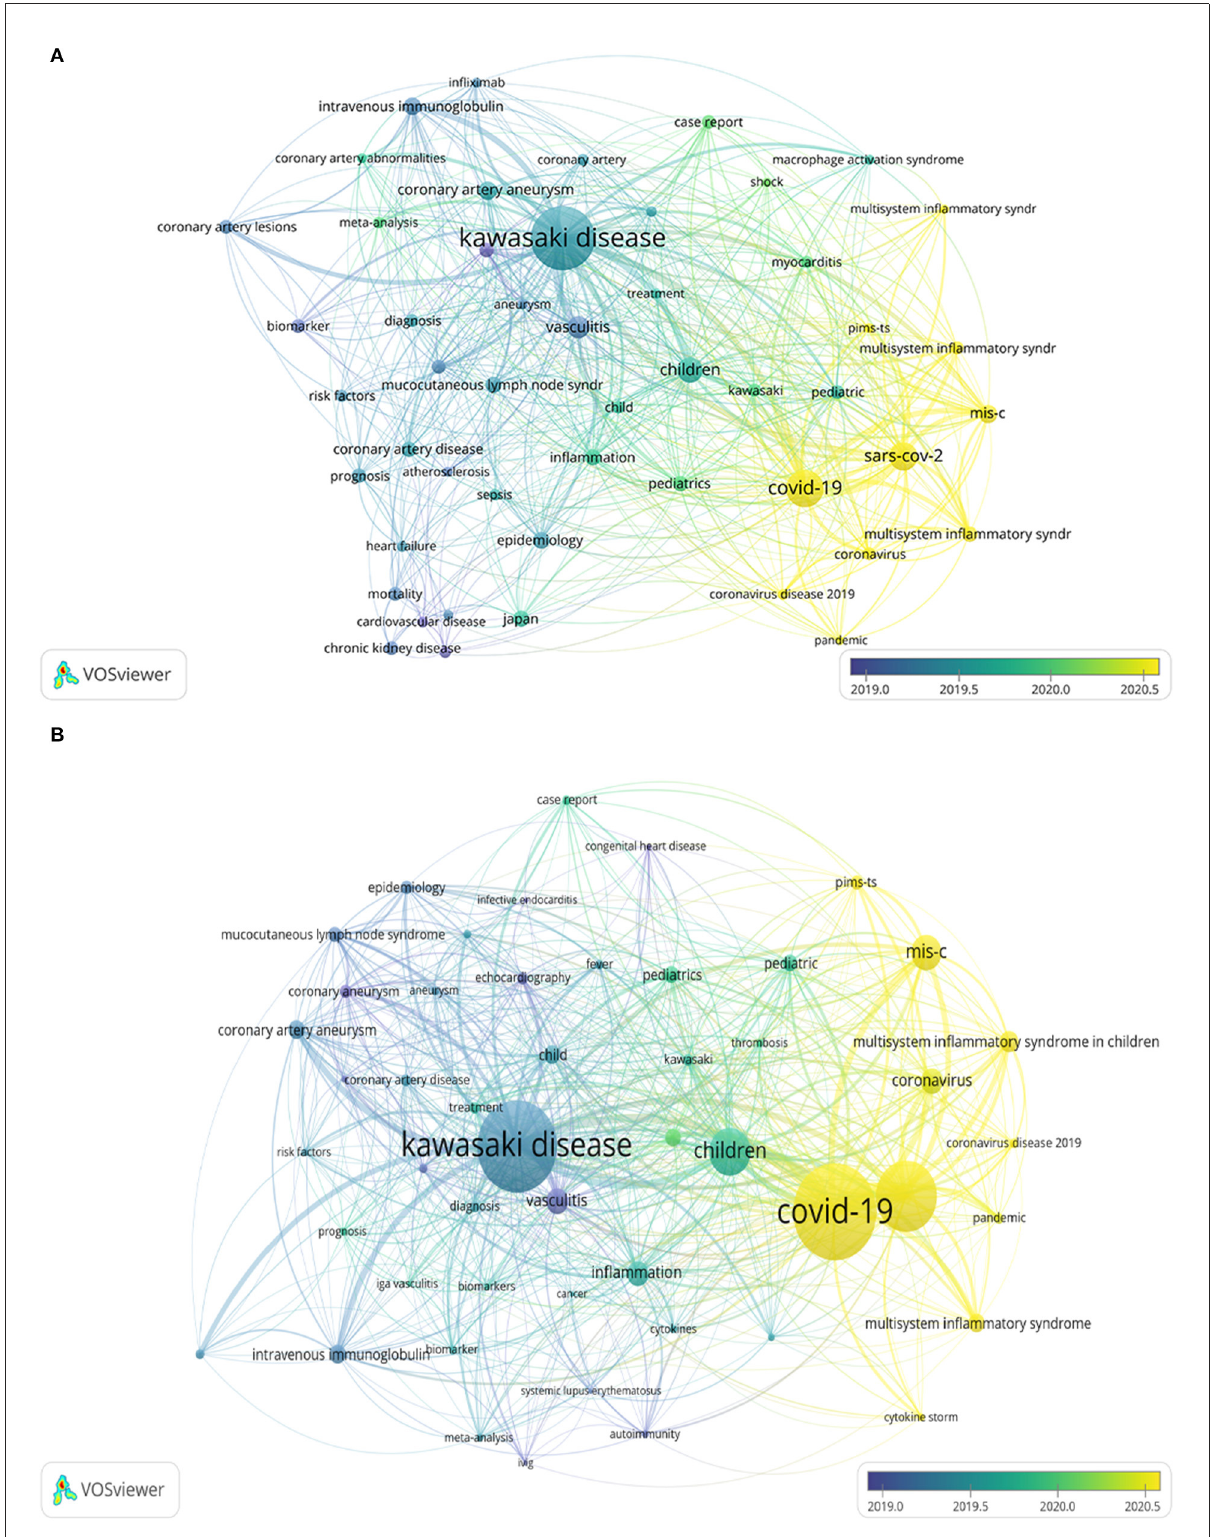
FIGURE7 Time-based visualization of keywords variation: (A) WOS and (B)